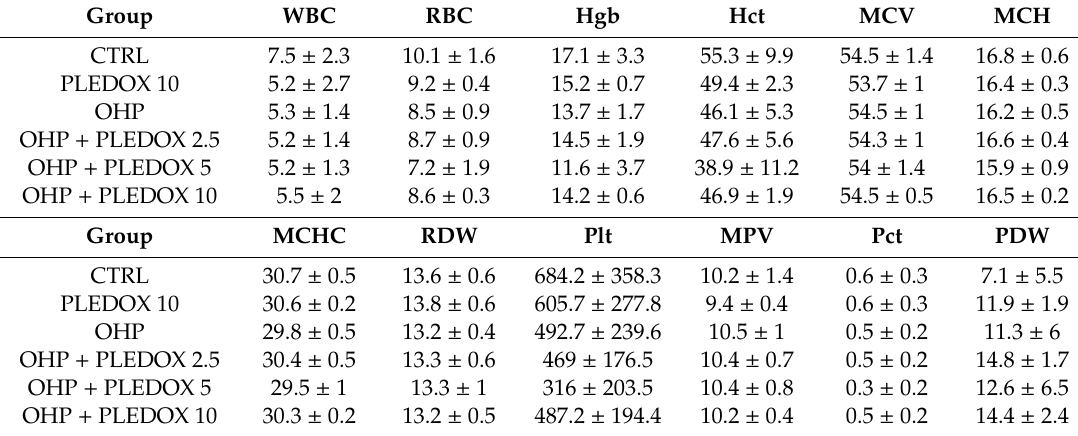
Table 2. Blood cell counts at the end of the follow-up period.